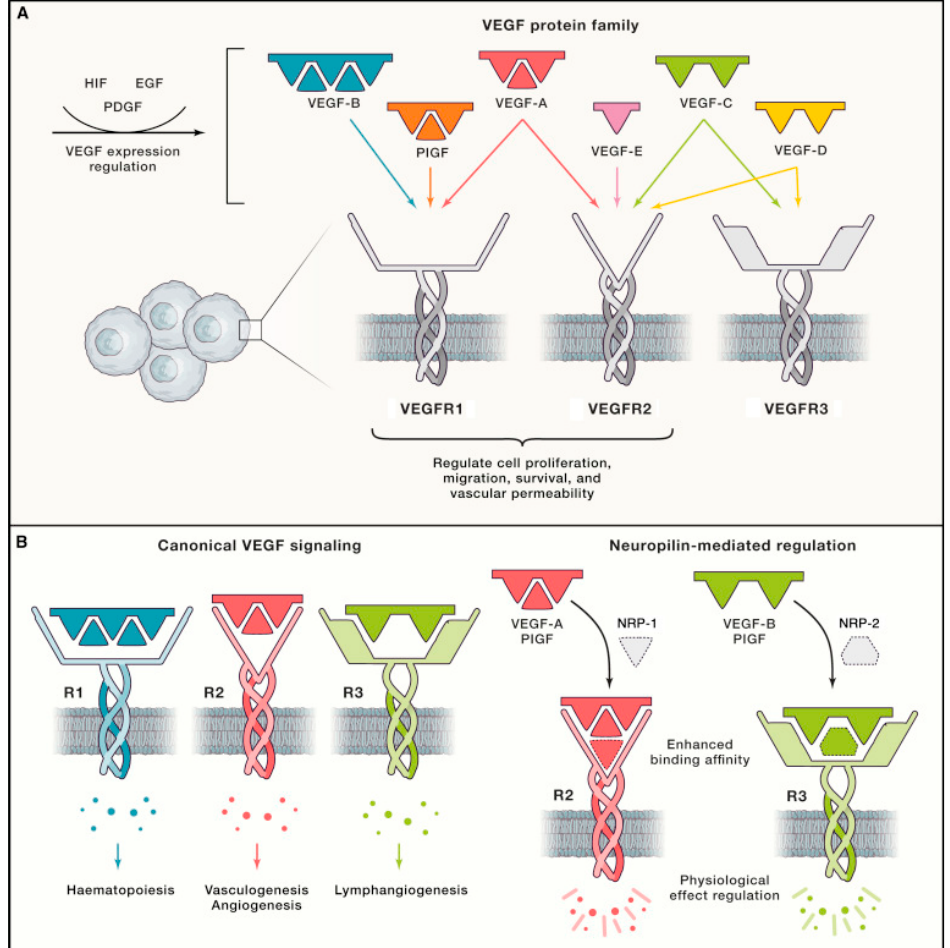
Figure 3. Schematic diagram of interactions between VEGFs and VEGFRs known to mediate hemangiogenesis and lymphangiogenesis. ( A ) The five major VEGFs expressed in mammals identified to date include VEGF-A to -D and placental growth factor (PlGF). VEGF-E is virally encoded. Each VEGF subtype interacts with either one or two of the three known VEGFRs to influence cell prolifera- tion, migration, survival, and vascular permeability. VEGF expression is regulated by various factors, including hypoxia-inducible factor (HIF), epidermal growth factor (EGF), and platelet-derived growth factor (PDGF). ( B ) Canonical VEGF–VEGFR signaling mediates vasculogenesis, hemangiogenesis, lymphangiogenesis, and hematopoiesis. Vascular endothelial cells express VEGFR-1 and -2, and VEGF-A/VEGFR-2 signaling is the primary driver of hemangiogenesis. LECs express VEGFR-2 and -3, and VEGF-C and -D/VEGFR-3 interactions are the main drivers of lymphangiogenesis. Neuropilin-1 and -2 (NRP-1/-2) act as coreceptors for VEGFR-2 and -3, respectively, increasing the affinity of VEGF–VEGFR binding [104]. Reproduced with